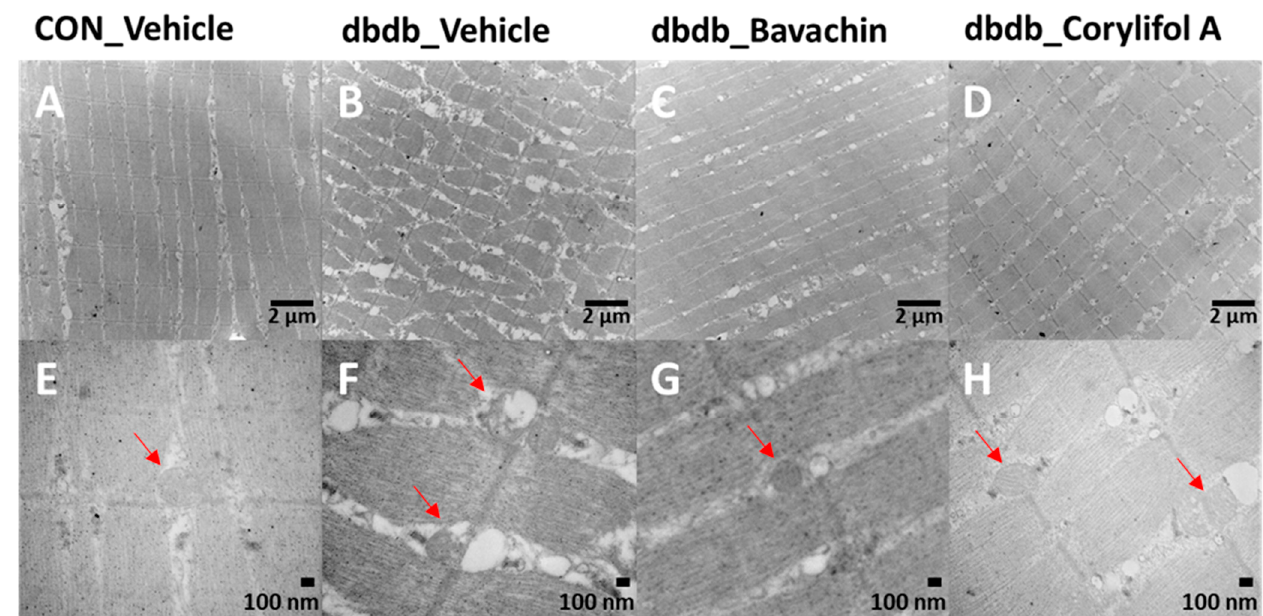
Figure 5. Bavachin and corylifol A improve the organization of muscle fibers and attenuate mitochondrial damage in skeletal muscles of db/db mice. Twelve week old male db/db mice were administered bavachin (10 mg/kg) or corylifol A (10 mg/kg) for 40 d. Transmission electron microscopy (TEM) of the GA muscle. ( A , E ) Control + vehicle, ( B , F ) db/db + vehicle, ( C , G ) db/db + bavachin, and ( D , H ) db/db + corylifol A groups. Red arrowheads indicate mitochondria. Images ( A – D ) were captured at 8000× magnification, and ( E , F ) at 20,000× magnification.